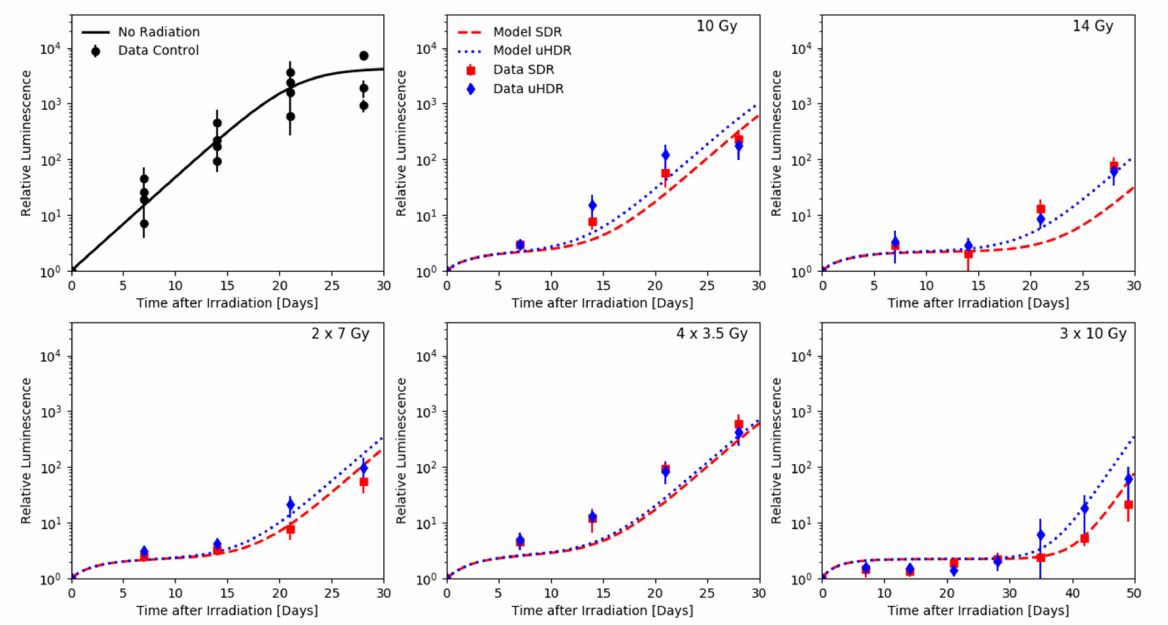
Figure 3. Growth of orthotopic glioblastoma based on H454 cells implanted in the striatum of nude mice, receiving no radiation (black) or irradiated 3 days post-injection with a 6 MeV electron beam set to either 0.1 Gy/s (SDR, red) or a single 1.8 µ s pulse (uHDR, blue) obtained via